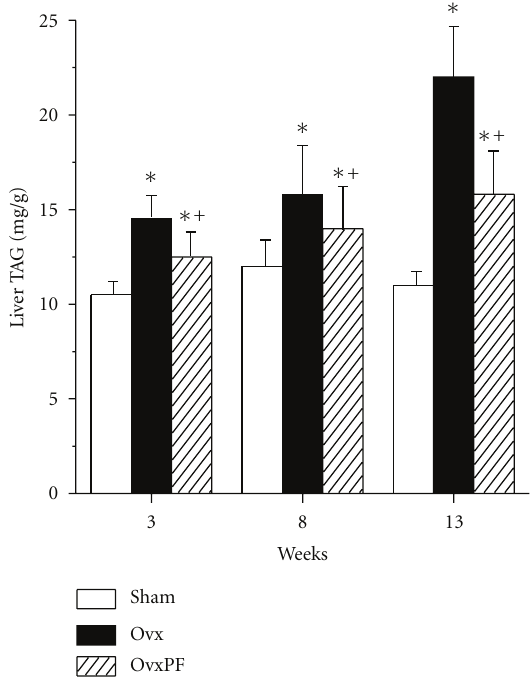
Figure 1: E ff ect of energy restriction in Ovx rats to the same level as food intake in intact rats on the hepatic TAG accumulation. n = 8/group. Sham: sham operated; Ovx: ovariectomized; OvxPF: Ovx rats paired fed to the level of Sham rats. ∗ Significantly di ff erent from Sham P < 0 . 05; + Significantly di ff erent from Ovx P < 0 . 05. Taken in part from Paquette et al.